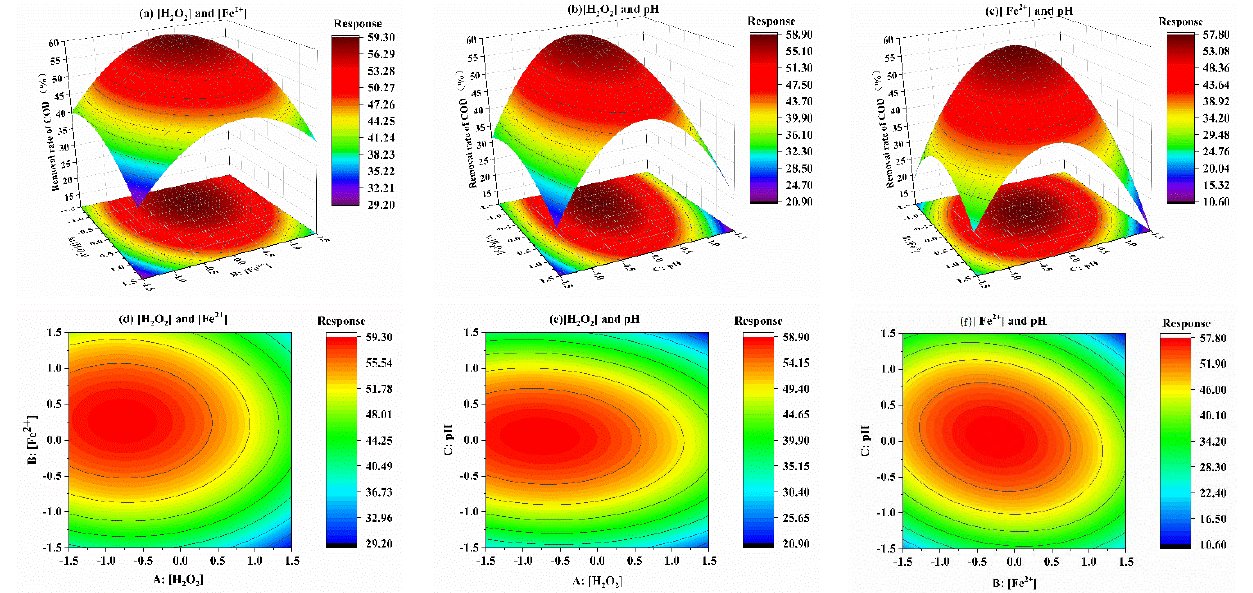
Figure 5. A three-dimensional response surface for the response of COD removal rate in terms of coded A and B ( a ), coded A and c ( b ), coded B and C ( c ); The corresponding contour plots for the response of COD removal rate in terms of coded A and B ( d ), coded A and c ( e ), coded B and C ( f ).